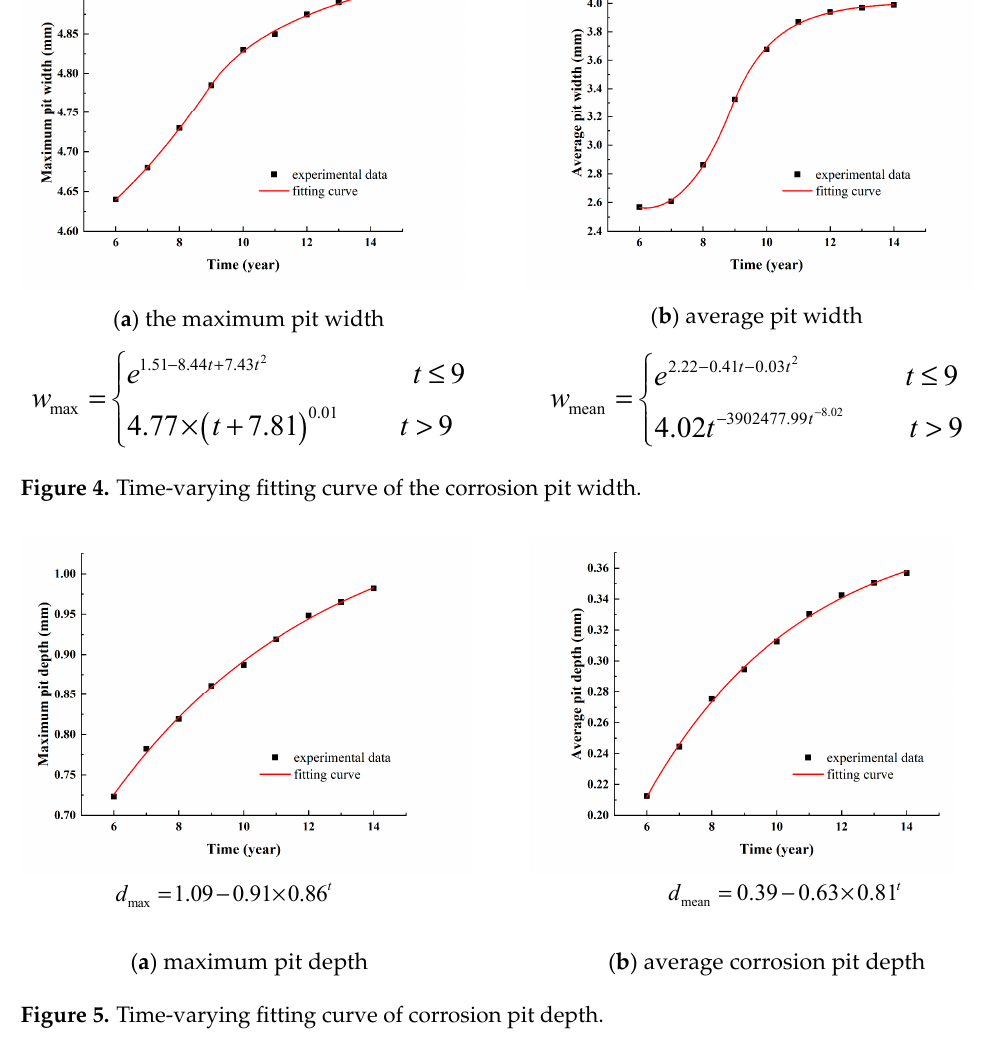
Figure 5. Time-varying fitting curve of corrosion pit depth.